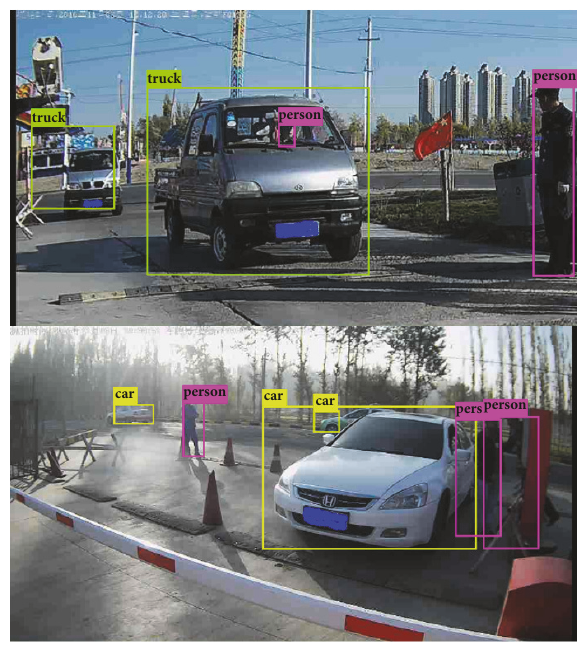
Figure 2: YOLOv2 detection. Top: truck. Down: